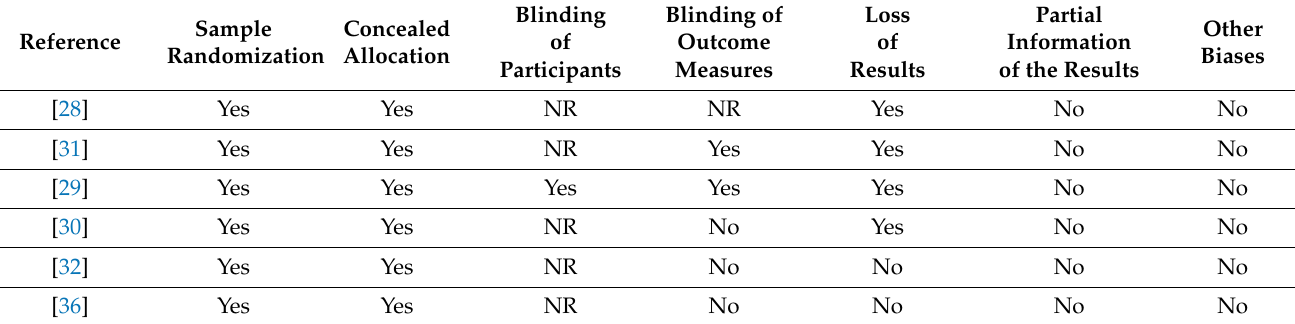
Table A3. Risk of bias of the